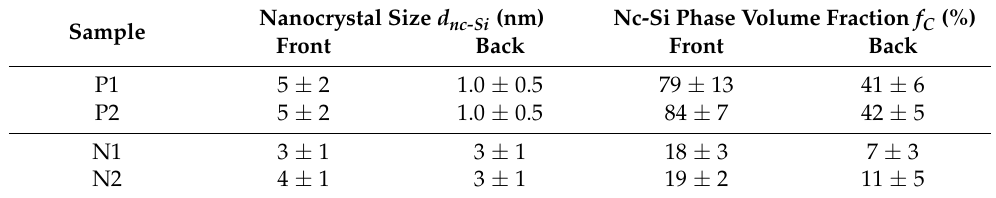
The calculated f C values are given in Table 2.